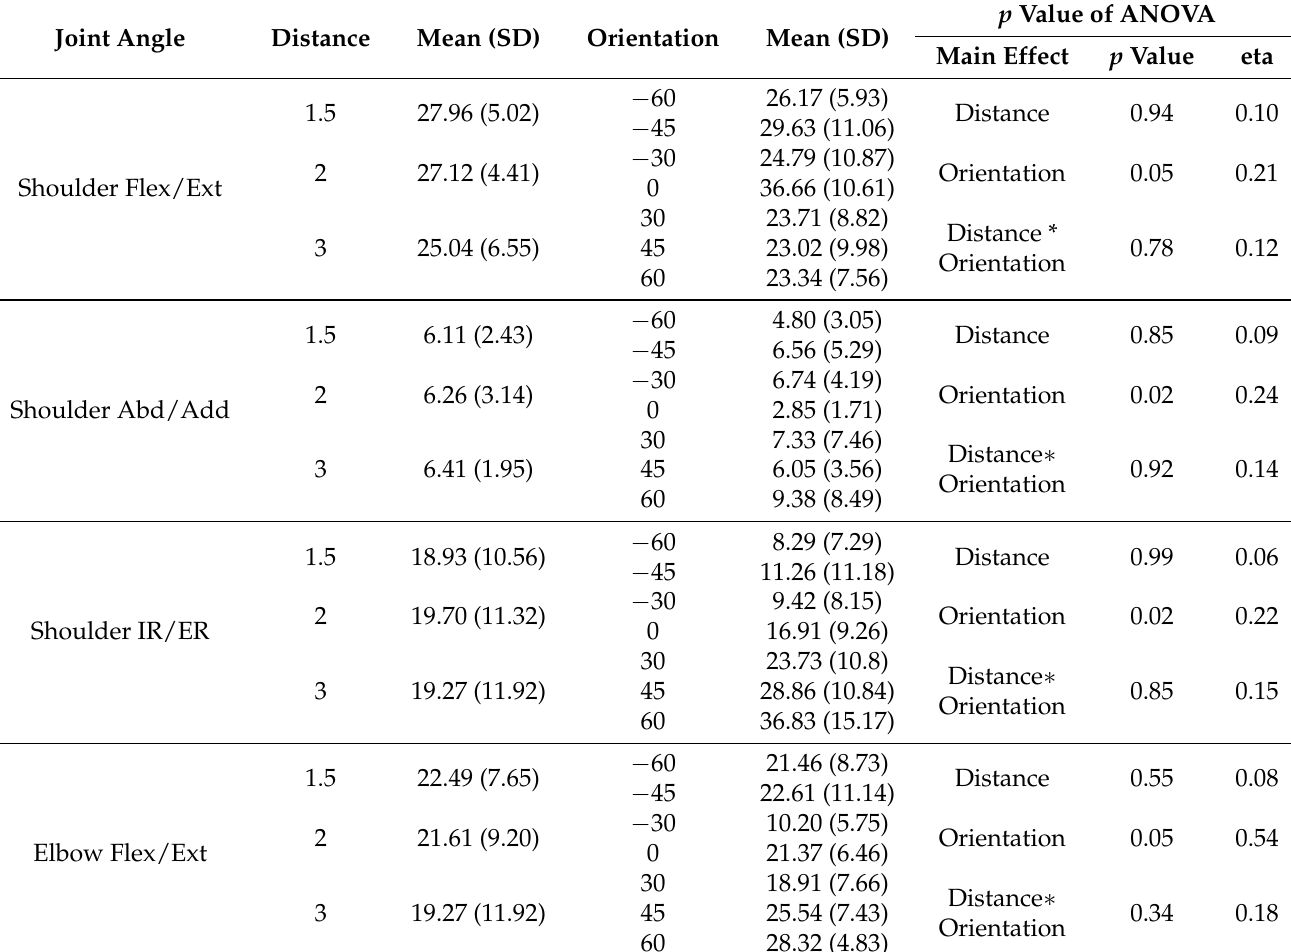
Table 2. Descriptive statistics of the mean absolute error of upper limb joint angles via the Kinect-based system in comparison with the Golden standard system and results of the two-way ANOVA in effects of location, orientation and their interaction (Distance * Orientation) on mean absolute